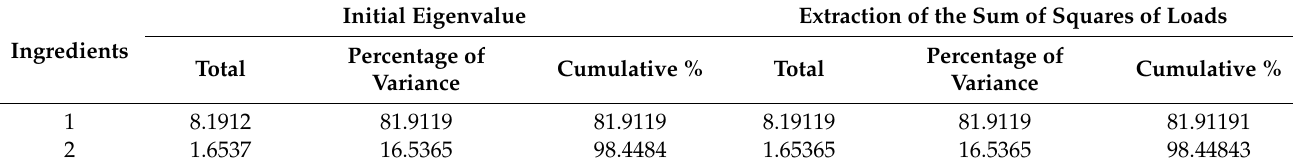
Table 4. Principal component load matrix of the driving